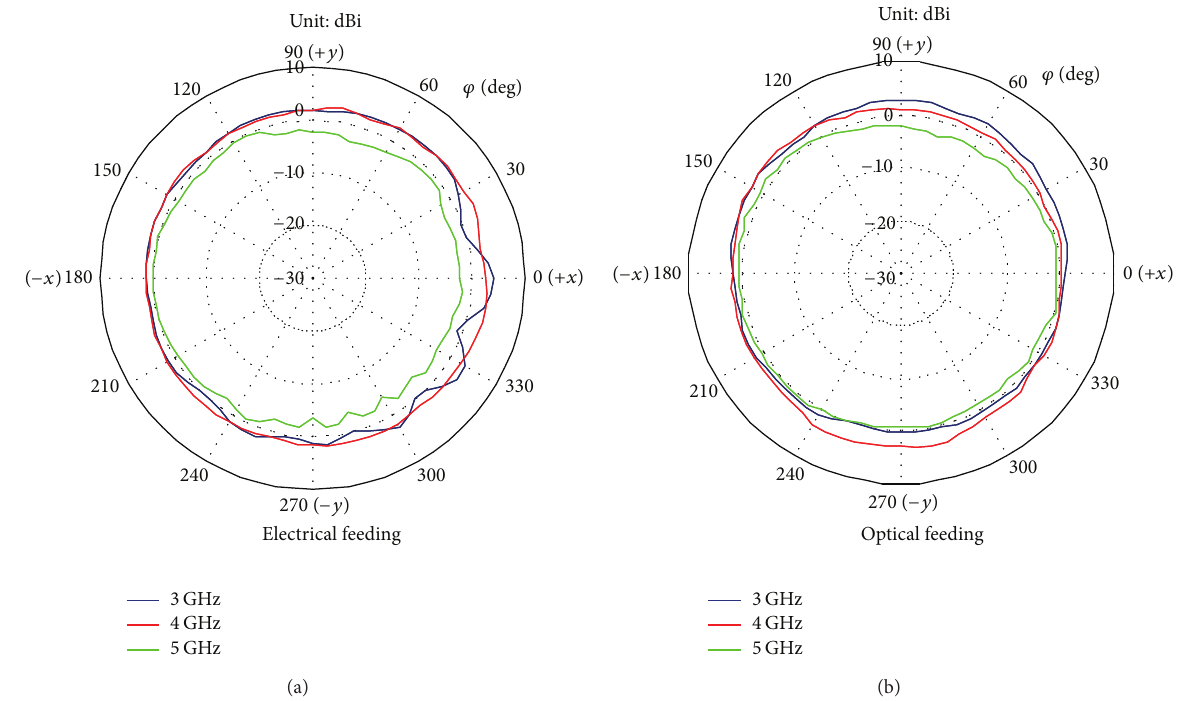
Figure 11: Measured radiation patterns for total field at 𝑥𝑦 -plane at several frequencies for Wirng A.